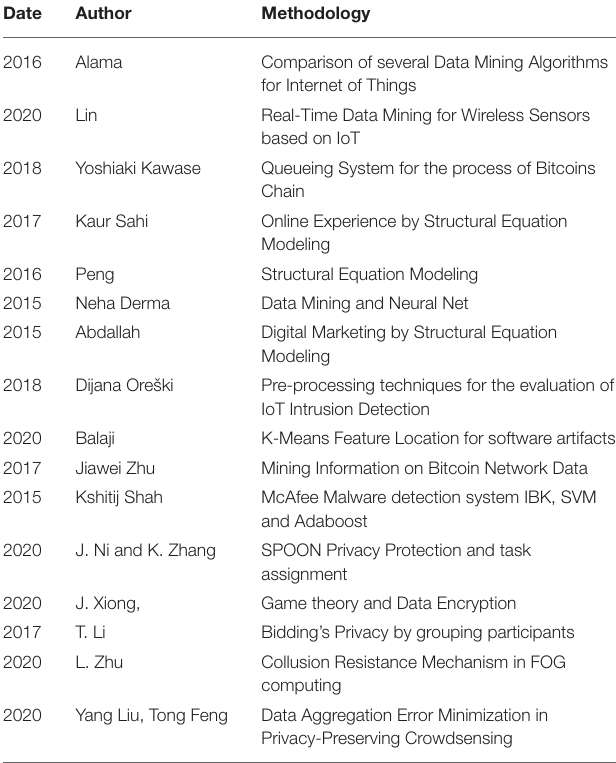
TABLE 1 | Literature